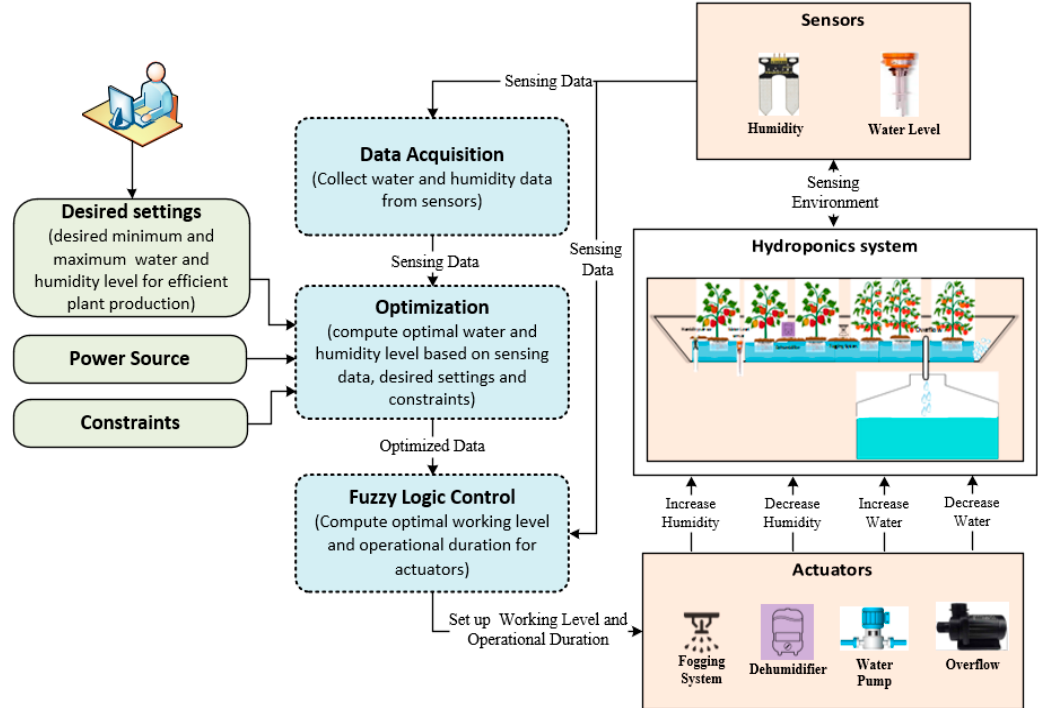
Figure3. Figure 3. Hydroponics model flowchart based on proposed optimization and fuzzy logic control scheme.